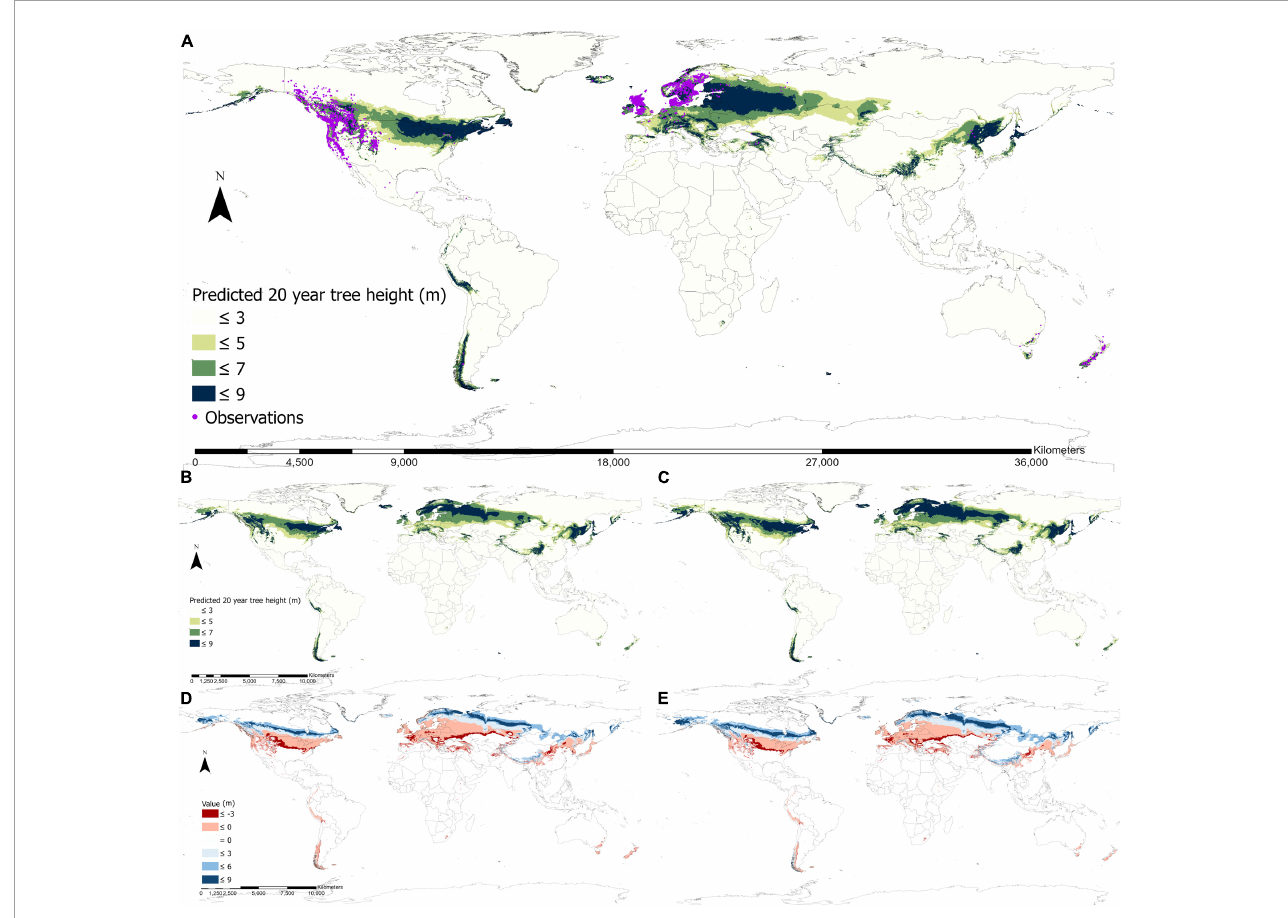
FIGURE4 Global distributions of the fundamental climate niche of lodgepole pine predicted by the final universal response function (fURF) for the current and the 2050s climates. The current fundamental climate niche distribution overlaid with the observed occurrence of lodgepole pine worldwide (A) , where each dot represents a single occurrence point. Potential growth performances (represented by 20-year height) by the 2050s with emission scenario RCP 4.5 using climatically local (B) , and optimal provenances (C) . Differences in the performance between the two future projections (B,C) and the current are shown in panels (D,E) ,